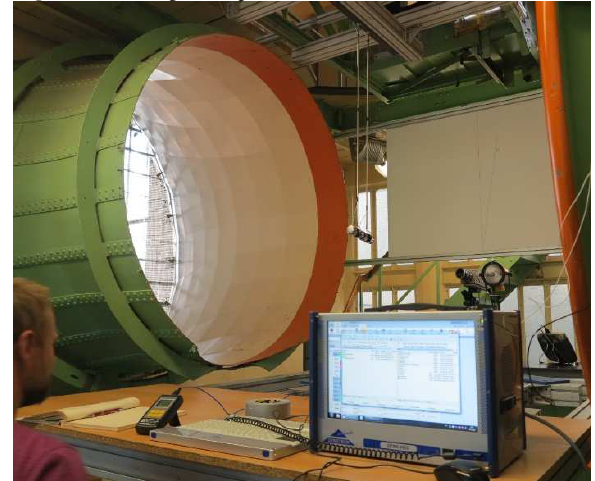
Fig. 15. Setup for measurement in the windchannel.